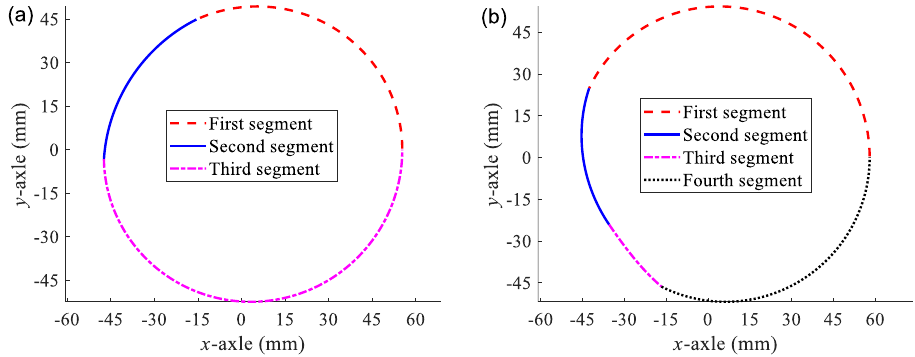
Figure 1. Pitch curves of piecewise deformed elliptical gears, ( a ) A = 50, e = 0.1, m 1 = 1.1, m 2 = 1.6, m 3 = 0.682, and ( b ) A = 50, e = 0.15, m 1 = 0.6, m 2 = 1.4, m 3 = 2.5, m 4 =